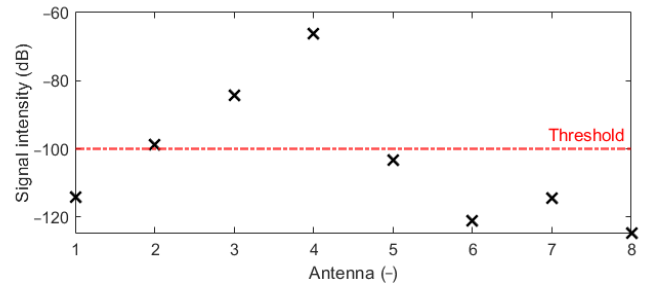
Figure 14. Hilbert envelope of differential signals calculated using 𝑆 𝑛𝑛 signals with the expected echo from the target.